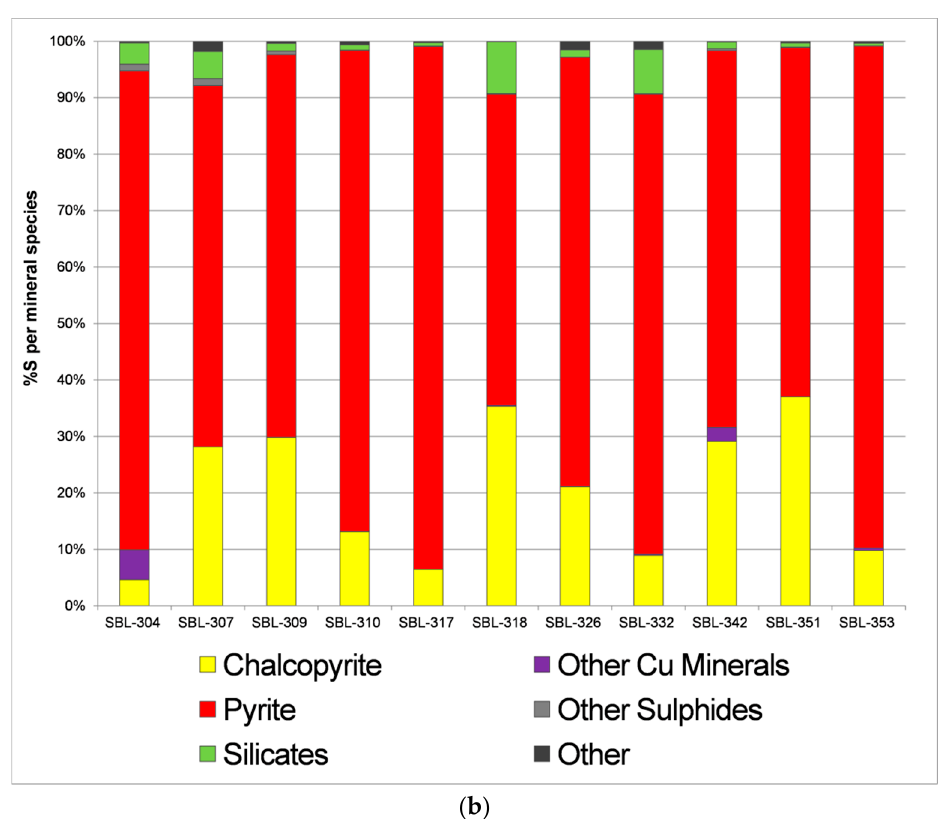
Figure 2. ( a ) QEMSCAN ® Elemental deportment charts for Fe and ( b ) S for 10 randomly chosen samples. Sulfur percentage in particular is strongly associated with pyrite in the samples.